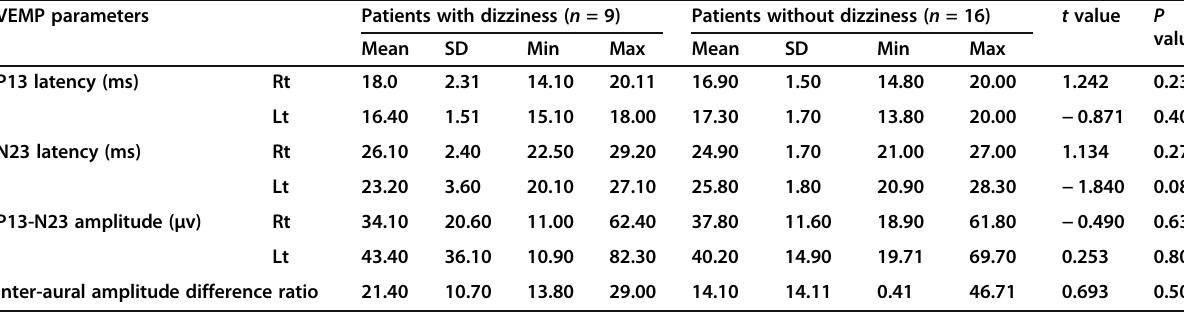
Table 8 Comparison between BD patients with and without dizziness regarding VEMP results VEMP parameters Patients with dizziness ( n =